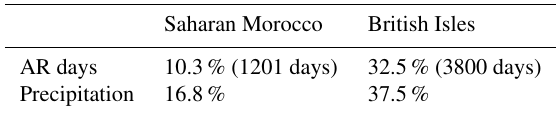
Table 1. Percentage of AR days and the associated precipitation rates out of the total for two Atlantic